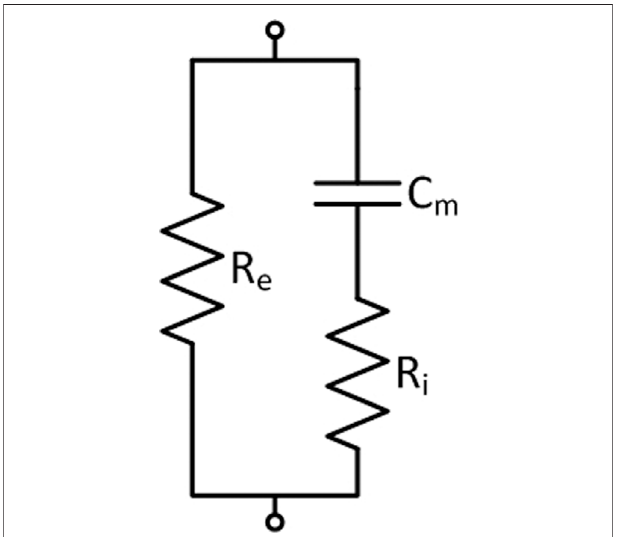
FIGURE 4 | Topology of the RRC networks used to simulate calf bioimpedance. Values and a visualization for the RRC networks can be found in Table 1 ; Figure 5 , respectively.